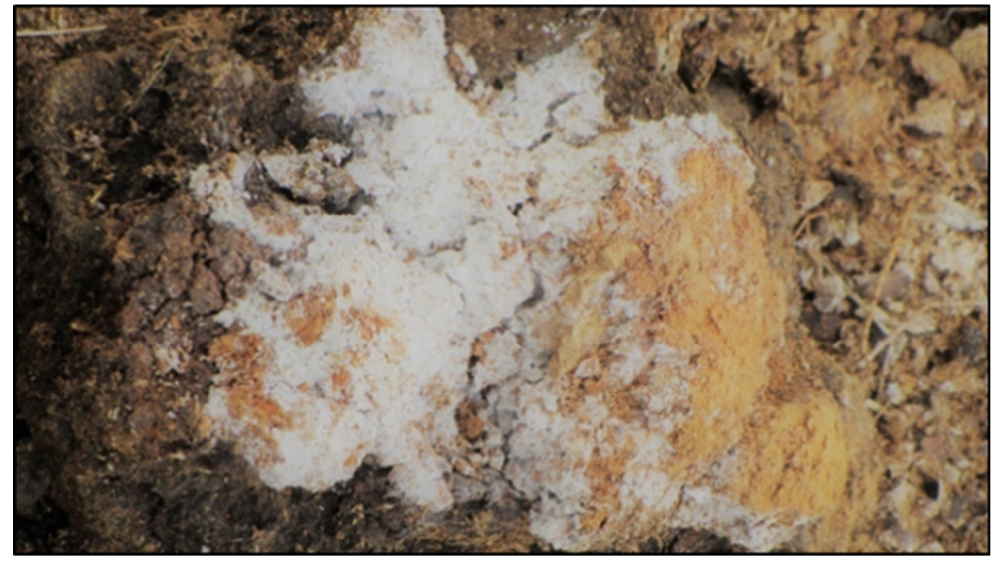
Figure 6. Exposure of a layer, at a depth of 20 cm, of salts in the sub-soil of the active sheep corral in Plugot forest.